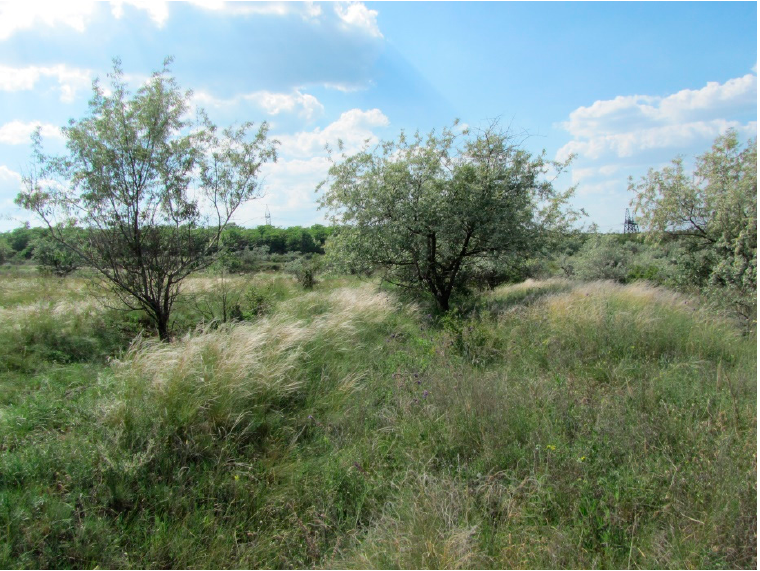
Figure 20. Restoration of steppe vegetation on artificial terraces. Stipa ucrainica is in the foreground (surroundings of Stara Emetivka village).